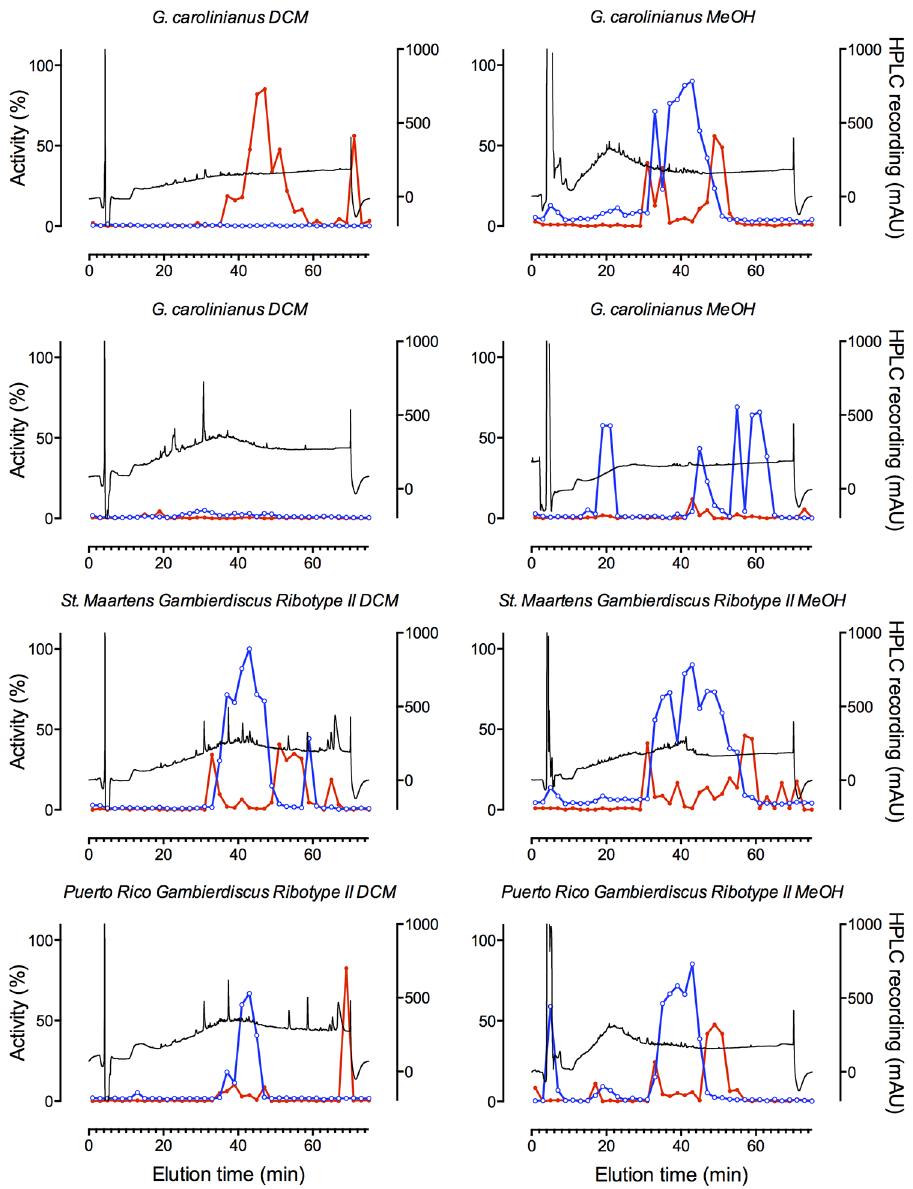
Fig 6. CTX-like and MTX-like activity in HPLC fractionated Gambierdiscus extracts from Caribbean/ Atlantic isolates. Dichloromethane (DCM) and methanol (MeOH) extracts of Belize G . carolinianus (Dive 1 Gam 1), North Carolina G . carolinianus (Kenny 6), St Maartens Gambierdiscus ribotype II (St. Maartens Gam 6) and Puerto Rico Gambierdiscus ribotype II (Mixed PR Gam 3) were fractionated by HPLC with MS detection (black trace). Fractions were tested for activity using the FLIPR TETRA assay. CTX-like (red trace) and MTX-like (blue trace) activity (%) is given relative to the most active MTX and CTX- containing fraction tested in this study.